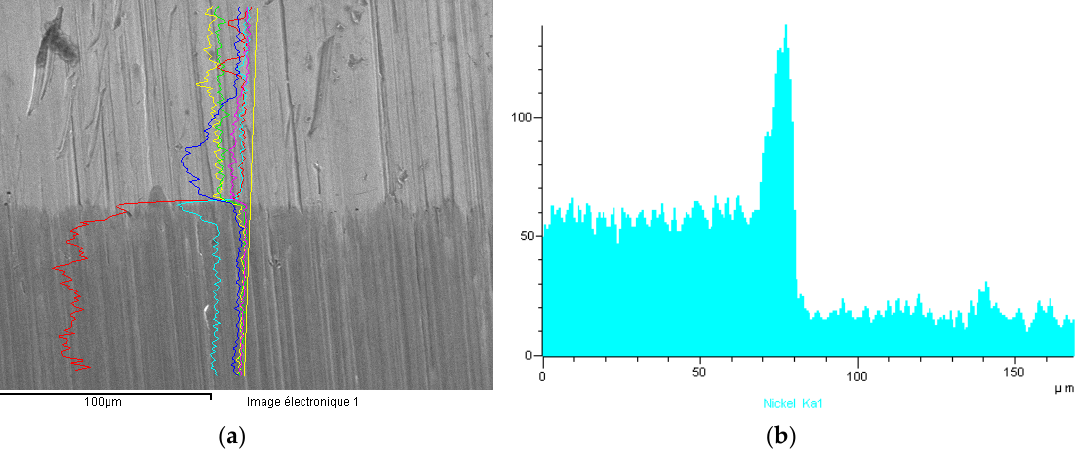
Figure 25. Sample #4. ( a ) EDX profiles of the gold-316 LM steel solder for iron, nickel, silver, gold, copper and zinc; ( b ) EDX Ni profile.